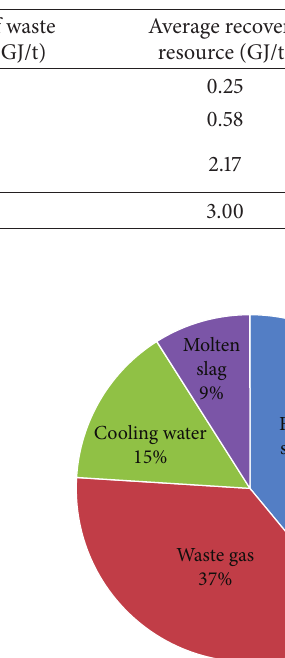
Table 4: Data of waste heat and resource and its recovery situation of CSI.